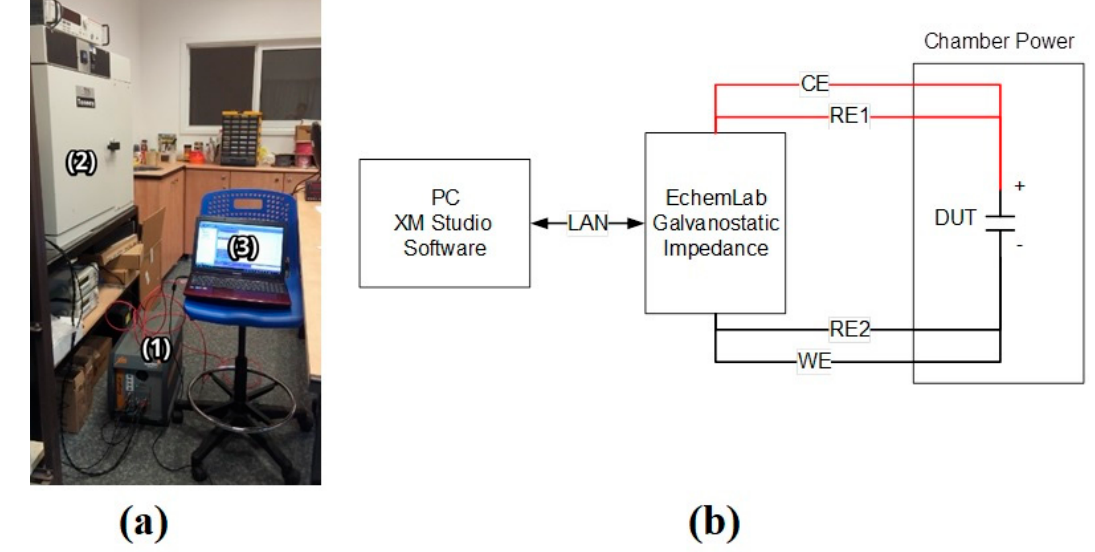
Figure 3. ( a ) Experimental setup of EIS measurements includes (1) potentiostat/galvanostat analyzer, (2) deep freezer chamber and (3) Laptop PC for data acquisition; ( b ) Schematic diagram of the experimental setup, where CE/WE are the main contacts, RE1/RE2 are the auxiliary contacts and DUT is device under